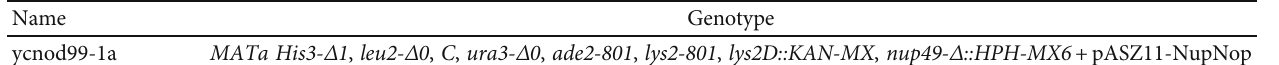
Table 1: Genotypes of strain used in this